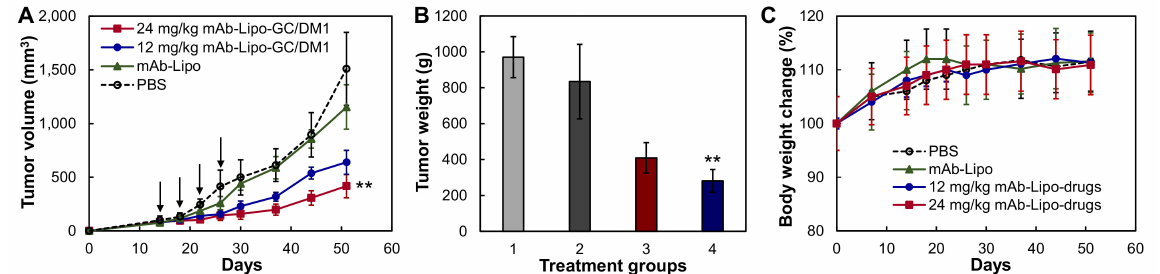
Figure 5. In vivo anti-TNBC efficacy of EGFR mAb-Lipo-drugs in MDA-MB-231-FLuc xenograft mouse models. ( A ) Tumor volume changes post treatment (data represent mean ± SEM, n = 5). PBS ( ), drug delivering vehicle mAb-Lipo ( (cid:78) ), (cid:35) 12 mg/kg mAb-Lipo-GC/DM1 ( • ) and 24 mg/kg mAbs-Lipo-GC/DM1 ( (cid:4) ). Tumor volume was measured with calipers, and calculated as ellipsoid. Black arrow indicating the i.v. injection of controls or therapies. ( B ) Wet weight of the tumors excised from euthanized mice. ( C ) The normalized body weight after treatment. ** p <0.005 vs. PBS using ANOVA followed by Dunnett’s t